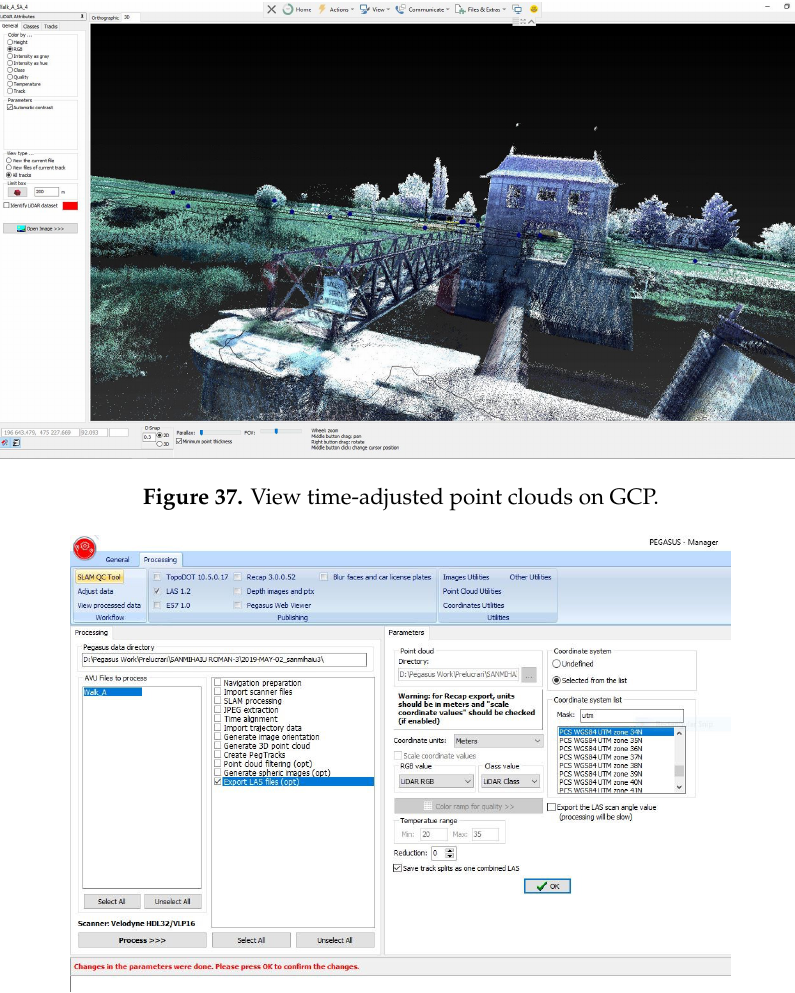
Figure 38. Export the LAS file (a file designed for the interchange and archiving of LIDAR point cloud